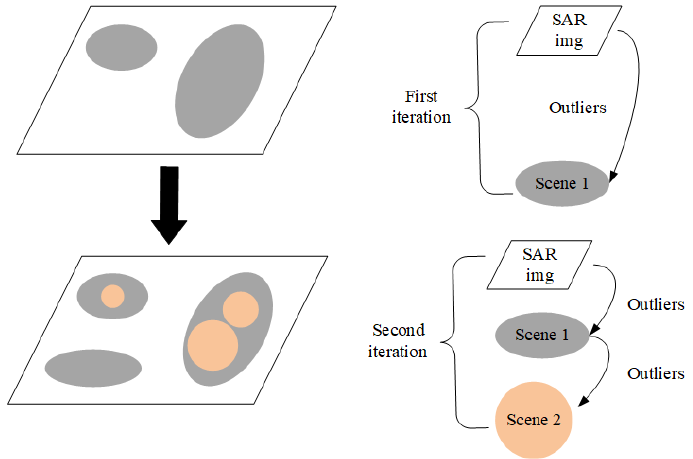
Figure 3. An example of iterative outlier